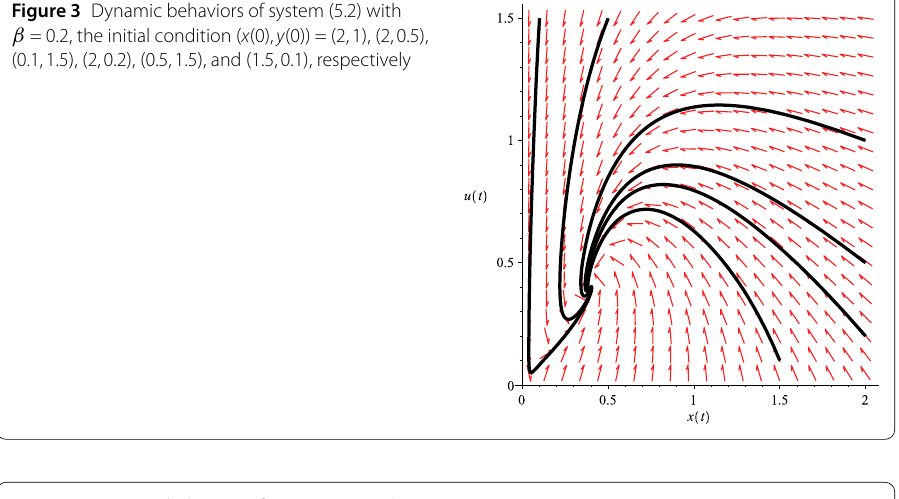
Figure 4 Dynamic behaviors of system (5.2) with β = 2, the initial condition ( x (0), y (0)) = (2,1), (2,0.5), (0.1,1), (2,0.2), and (0.5,1),